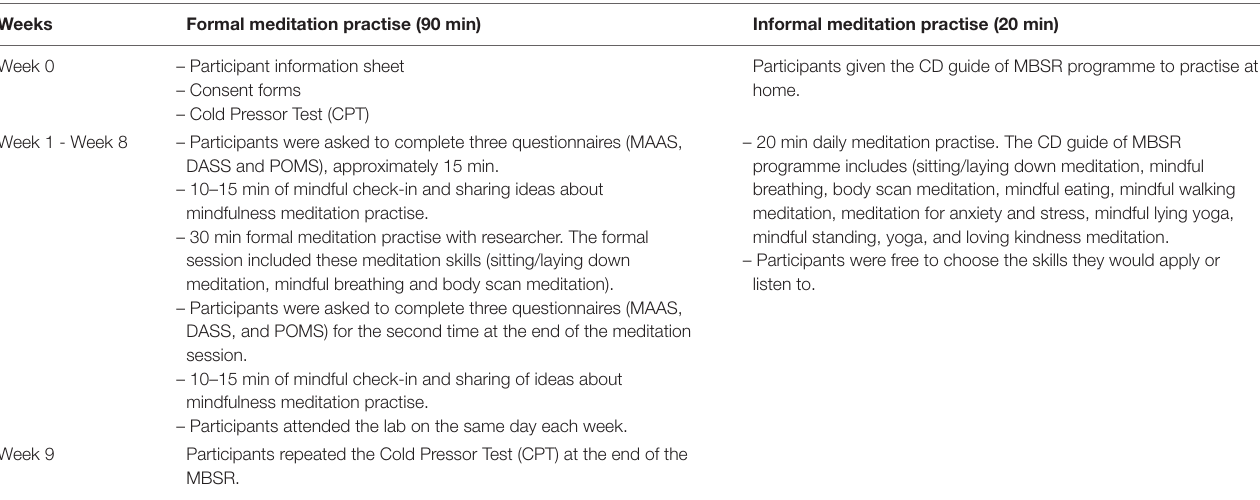
Big Toe/ Proximal phalanx Running Left Side Toe Right Hand ACL, Anterior cruciate ligament. The labels used in the typology of injury were labels given by the injured athlete. These injuries either occurred during participation in the sport or during training. The two groups did not differ in age, t(18) = 0.083, P = 0.935, (m intervention = 28.9 years, SD = 6.21; m control = 28.7, SD = 4.47) or gender, χ 2 = 0.952, P = 0.329. TABLE 2 | Mindfulness-Based Stress Reduction (MBSR) that was used in this study with injured athletes in the intervention group. Weeks Formal meditation practise (90 min) Informal meditation practise (20 min) Week 0 Participants given the CD guide of MBSR programme to practise at